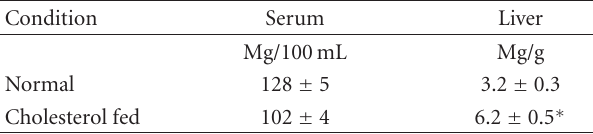
Table 2: Serum and liver cholesterol levels.